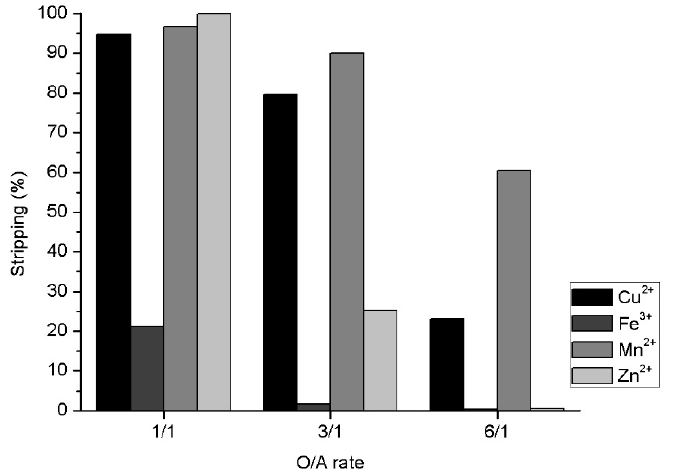
Figure 5. Effect of O/A ratio on the stripping percentage of metals from the organic loaded phases. Experimental conditions: [R 4 NCy] = 0.54 M, [H 2 SO 4 ] = 1 M, 400 min − 1 , and 20 min of stirring time.